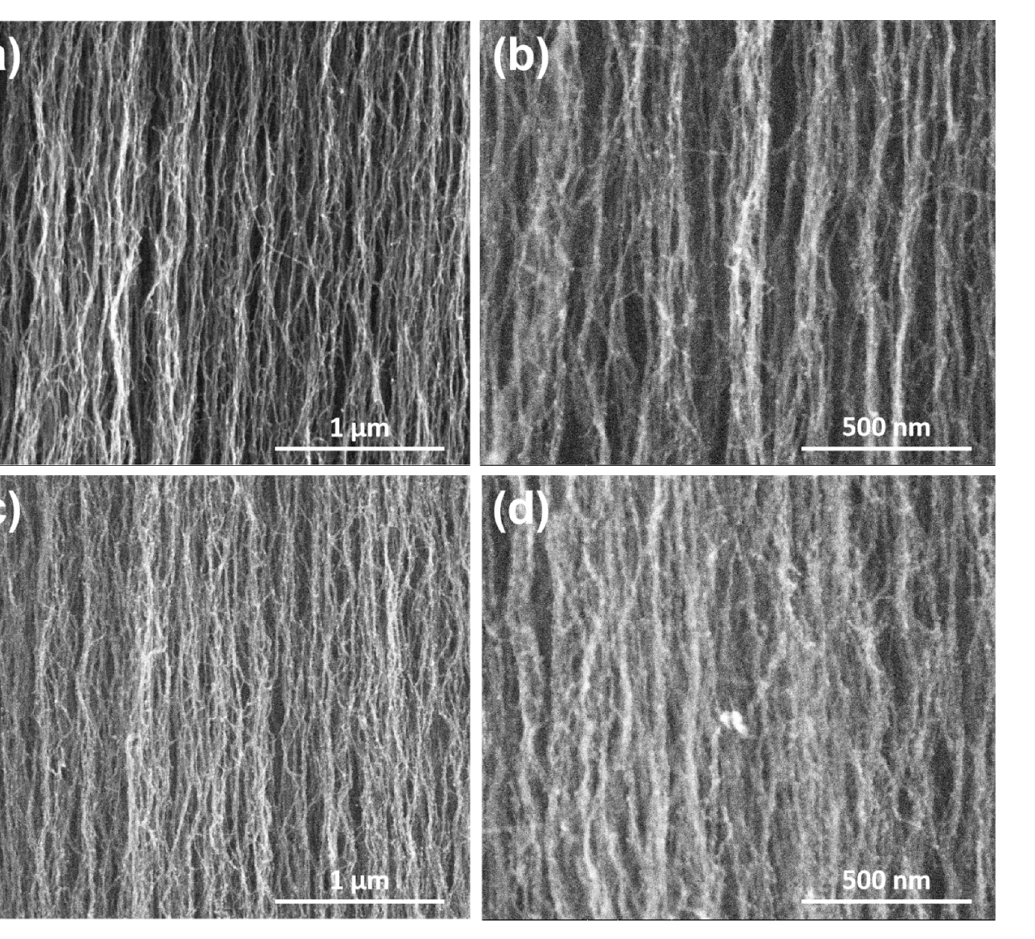
Figure 4. Cross-sectional FESEM images of Fe 3 O 4 /VACNTs composites at different magnifications. ( a , b ) Fe 3 O 4 /VACNTs-17.2%; ( c , d ) Fe 3 O 4 /VACNTs-41.9%.